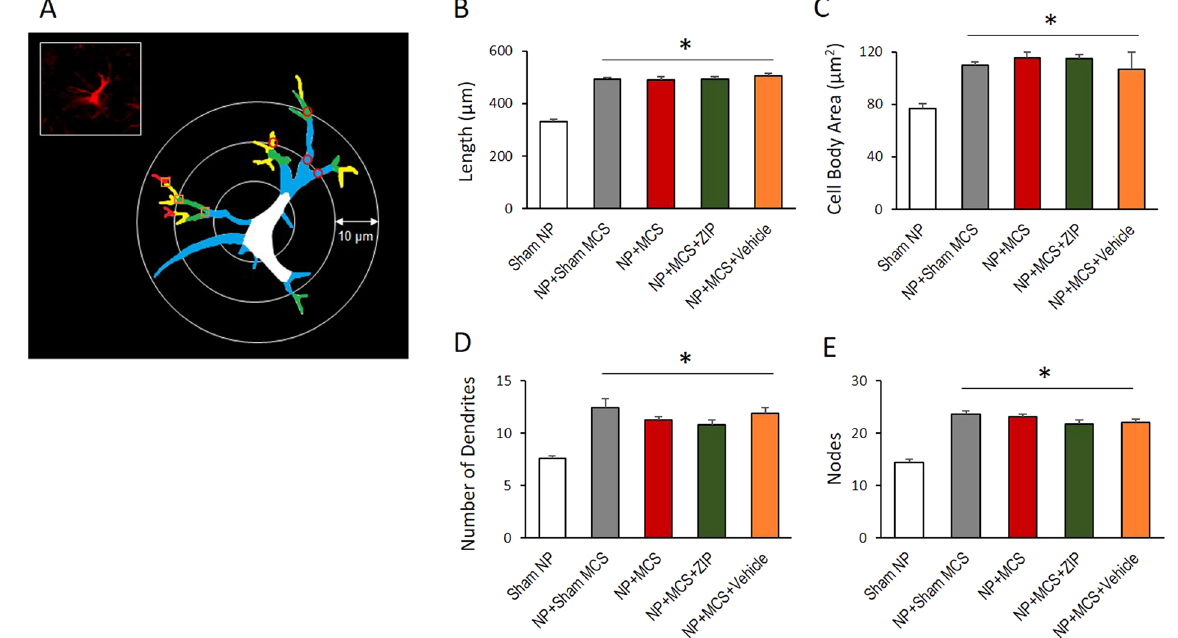
Figure 8. Neuropathic pain and MCS induce astrocytic hypertrophy. ( A ) Schematic of astrocytes and the parameters measured. Astrocytes were identified using a GFAP antibody, and images were then analyzed. The colors on the images indicate different morphological features: White = cell body, Blue = first-order branch, Green = second-order branch, Yellow = third-order branch, and Red = fourth-order branch; Red square = branch point; and Red circle = intersections. ( B ) The total length of the astrocytic processes from the ACC regions. The total length of the astrocytic processes in different groups was significantly increased compared with the sham NP group. ( C ) The cell body areas of astrocytes in the ACC. The cell body areas of the astrocytes in different groups were increased significantly compared with the sham NP group. ( D ) The number of dendrites in different groups. There were significant increases in the number of primary (first-order) processes in experimental groups compared with the sham NP group. ( E ) The number of nodes in different groups. The numbers of nodes (second to fourth-order branch) in the experimental groups were significantly increased compared with the sham NP groups. Taken together, peripheral neuropathy induced astrocytic hypertrophy; however, MCS or ZIP did not interfere with this response. * P < 0.05 compared with sham